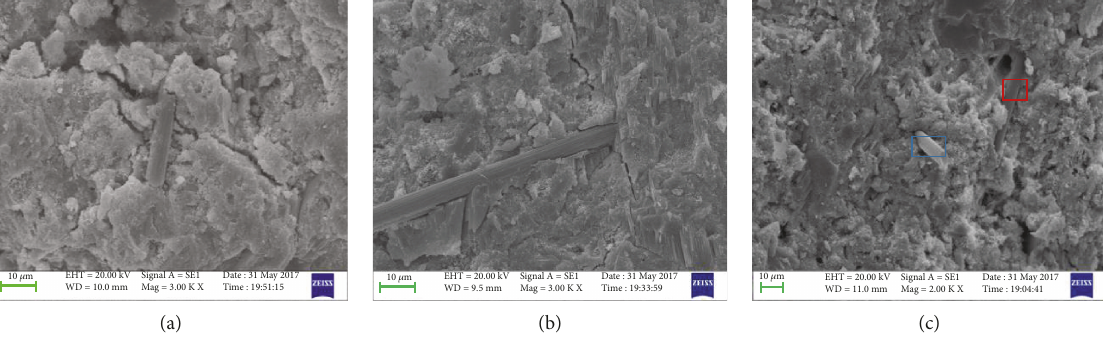
Figure 10: SEM pattern of cement stone with